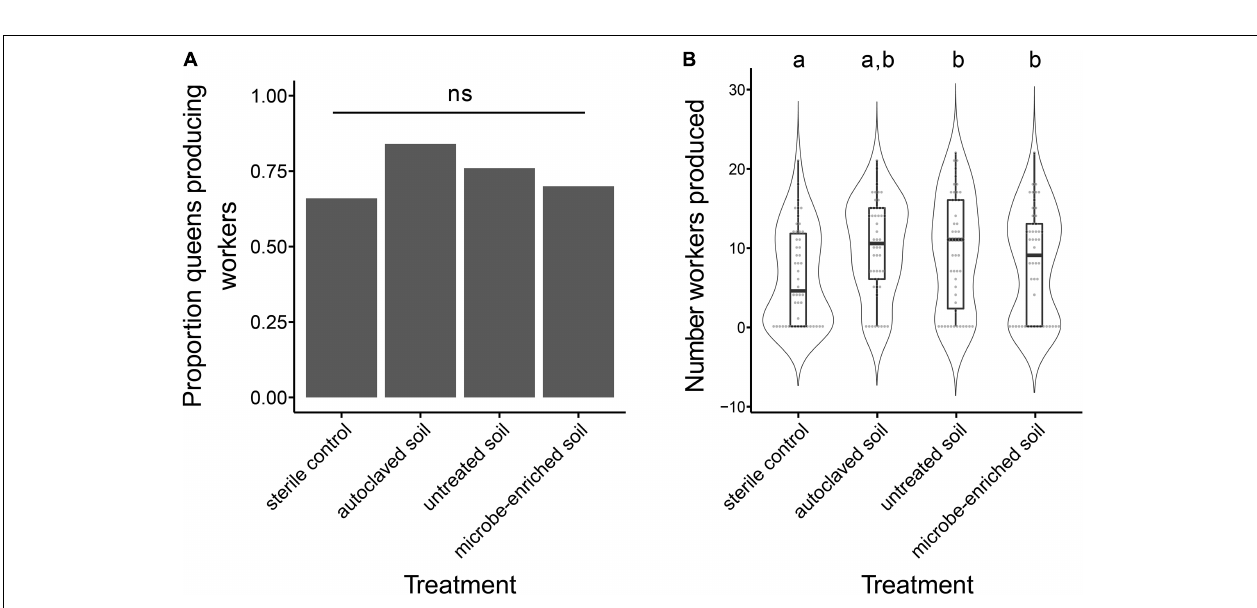
FIGURE 2 | The proportion of queens producing workers (A) and the number of workers produced (B) before hibernation for the different environmental treatments (sterile control, autoclaved soil, untreated soil, and microbe-enriched soil) in the founding experiment. Bars represent the proportion of queens producing workers while boxplots show the median number of workers, as well as the upper and lower quartiles, with whiskers encompassing 1.5 times the interquartile range. Violins around the boxplots show the probability density of the data and gray points show the distribution into discrete bins. Small letters indicate statistically significant different groups at α = 0.05, while ns indicates non-significant